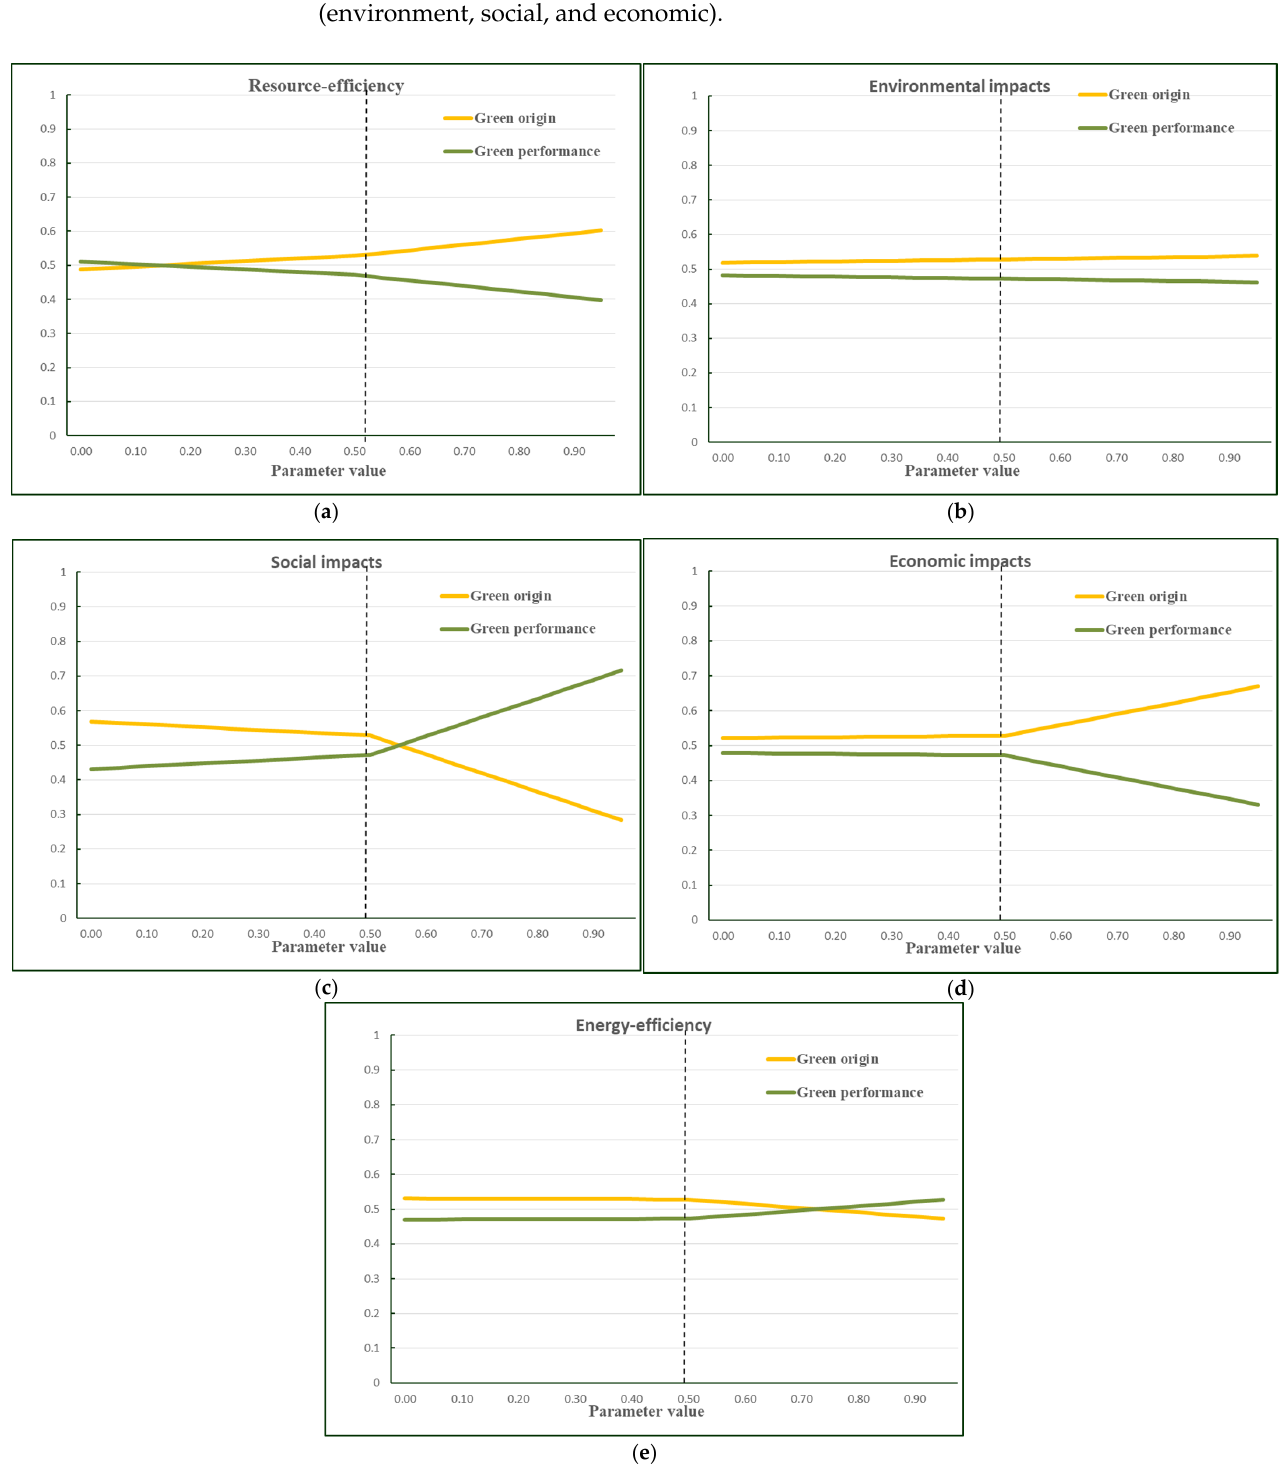
Figure 5. Sensitivity analysis concerning ( a ) local weights, ( b ) global weight.